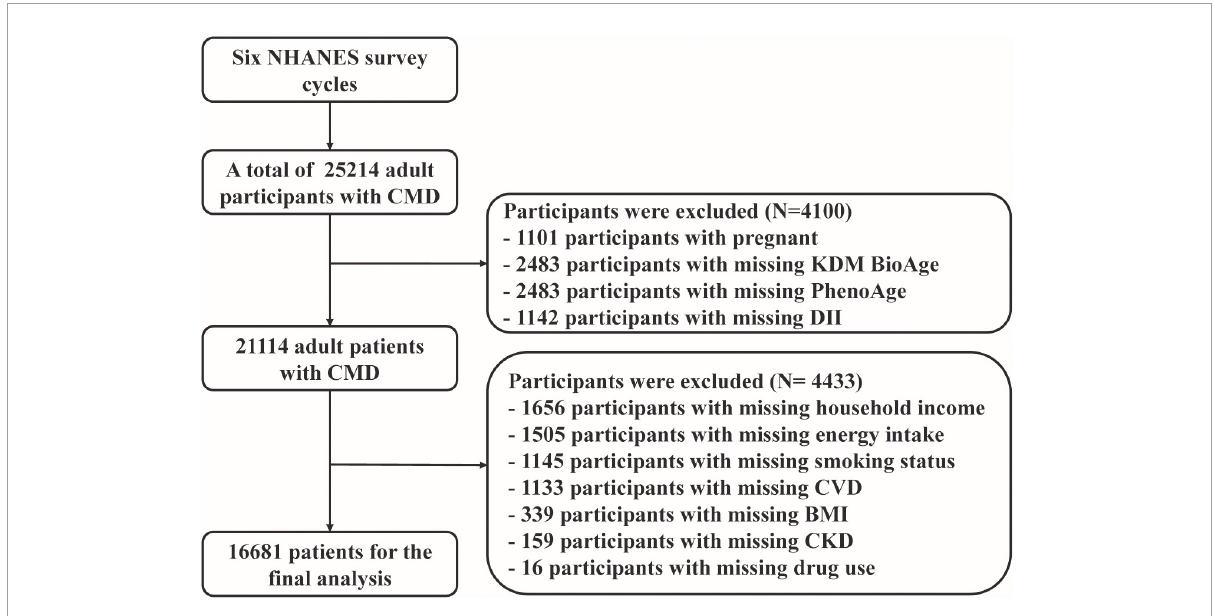
FIGURE1 Flowchart of conforms the analytic